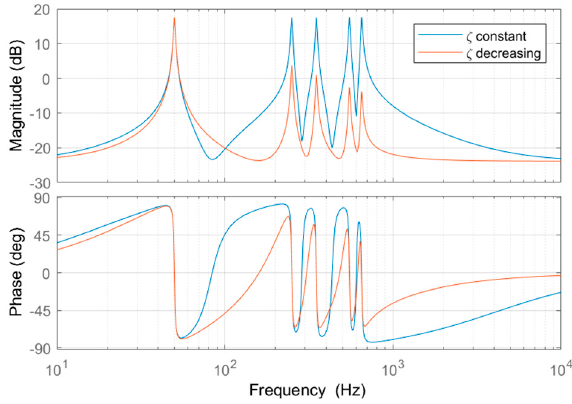
Figure 6. Bode plot of a proportional multi-resonant (PMR) controller with constant and decreasing gain for higher order resonances.